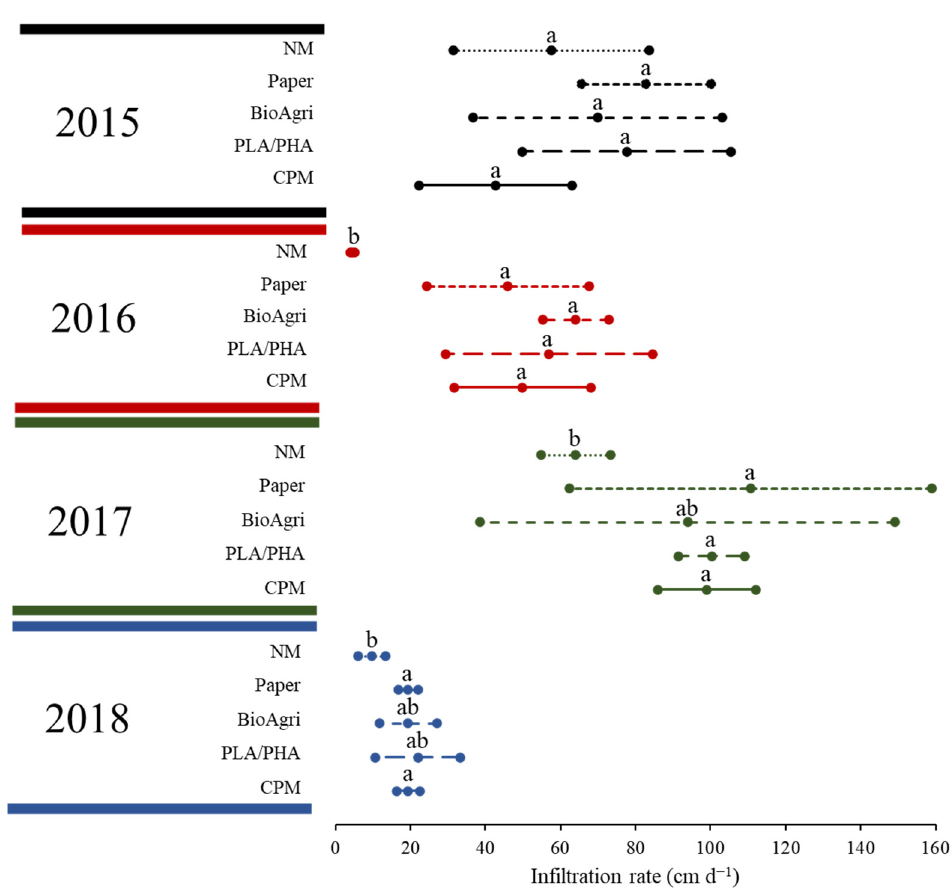
Figure 9. Average soil water infiltration rates (and relative 95% confidence intervals) obtained in response to the different mulching treatments in the experiment by Sintim et al. [160]. The values were grouped by year. Different letters within each year indicate significant differences between treatments (p ≤ 0.05). BioAgri: biodegradable film composed by starch and PBAT; NM: no mulch; PLA/PHA: biodegradable film composed by PLA and PHA; CPM: conventional plastic mulch (PE); paper: cellulosic-paper